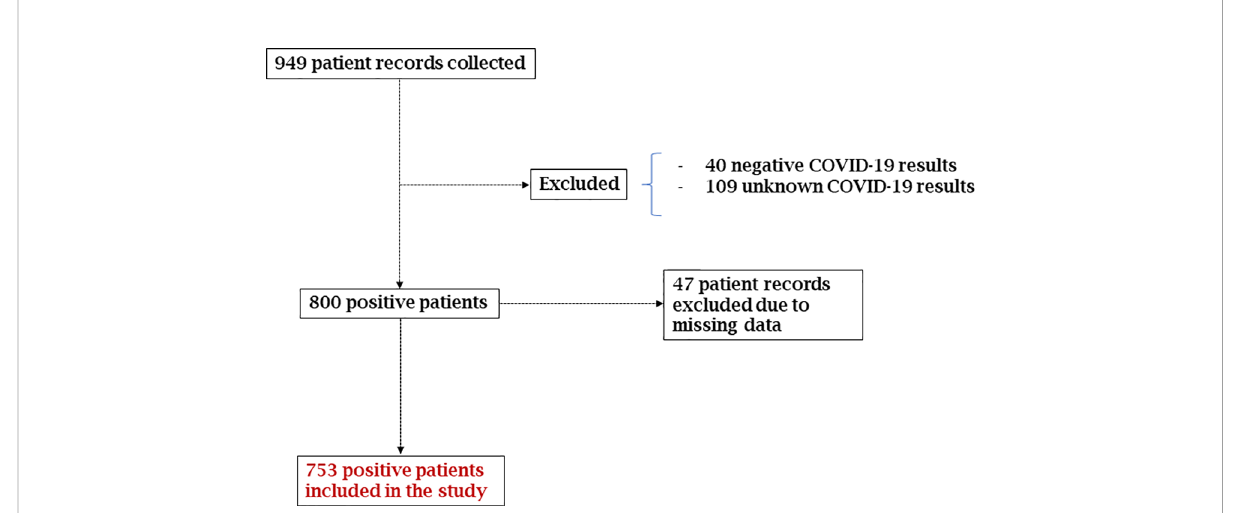
FIGURE 2 Chart of the management of COVID-19 positive patient records included in the